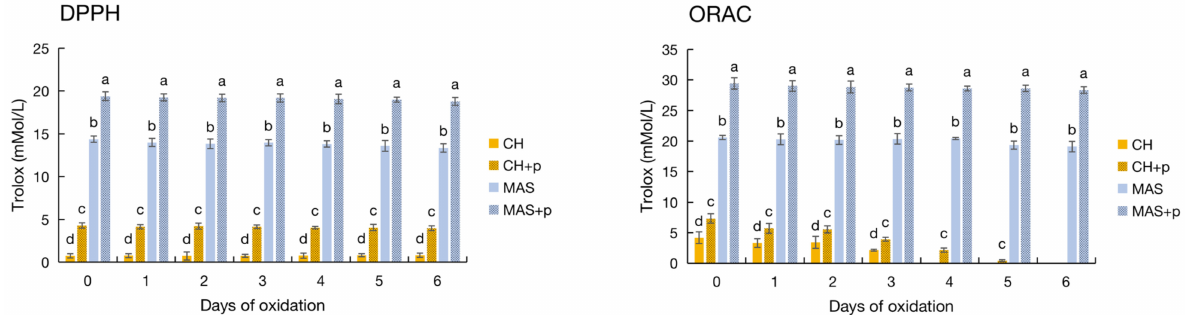
Figure 6. Antioxidant indices of Chardonnay and Marselan wines with pyrogallol during oxidation. Different letters indicate significant differences among values at the same date using Duncan’s test ( p ≤